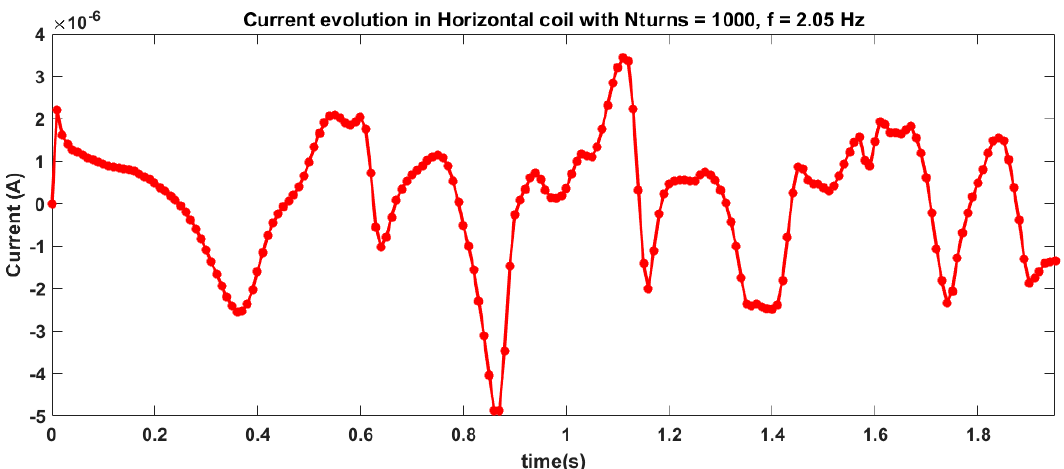
Figure A33. Current evolution for horizontal coil with 1000 turns for case 7 of magnet arrangement and 2.05 Hz frequency of excita-tion.